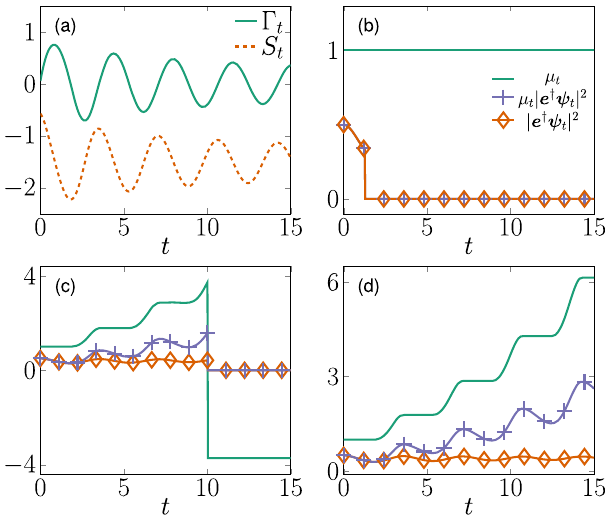
Fig. 1 Illustration of qubit state and in fl uence martingale trajectories. a Time dependence of the weight function Γ t (full line) and the Lamb shift S t (dashed), de fi ned as in (17). b – d Different realizations of the stochastic evolution displaying e y ψ t line), where the system state ψ t and in fl uence martingale according to μ t (6) and (9). The initial data are ψ respectively the ground and excited states of H = σ + σ −